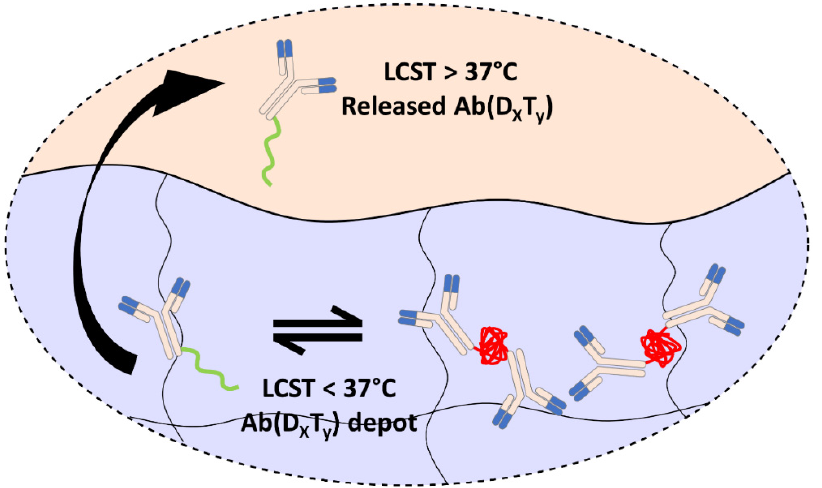
Figure 1. Local LCST depression of PEGMA-antibody conjugates (Ab(D x T y )) within a zwitterionic hydrogel for the controlled release of solubilized conjugates. Within the hydrogel, the Ab(D x T y ) aggregates form due to hydrogel promoted LCST depression and slowly dissolve for controlled release. PEGMA copolymers of diethylene glycol methyl ether methacrylate (D) and triethylene glycol methyl ether methacrylate (T) P(D x T y ) were synthesized to achieve temperature-sensitive polymers with suitable and hydrogel promoted phase transitions for Ab(D x T y ). The conjugates were designed to undergo phase transitions within but not outside of the hydrogel.